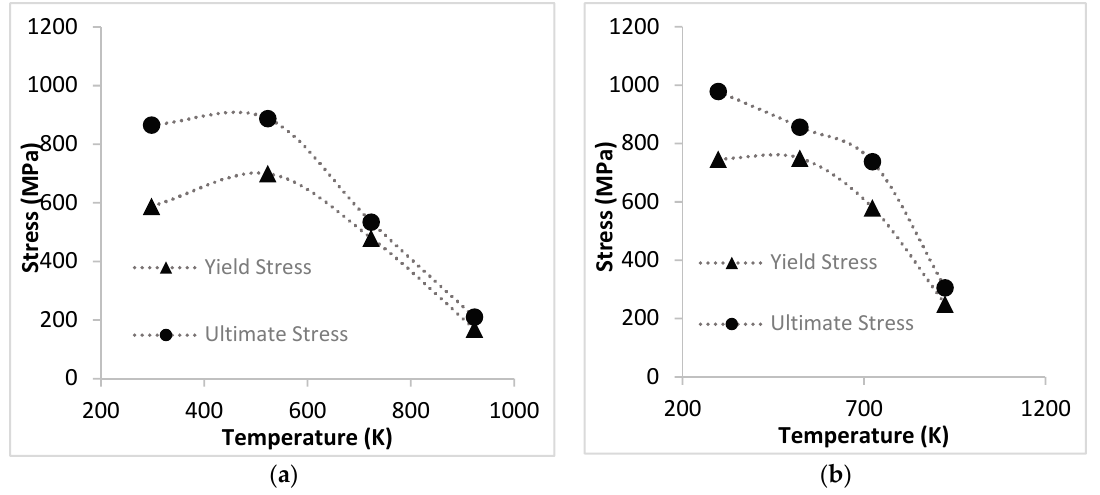
Figure 5. Stress variations with temperature at a strain rate of ( a ) 0.0015 s − 1 and ( b ) 0.15 s − 1 .